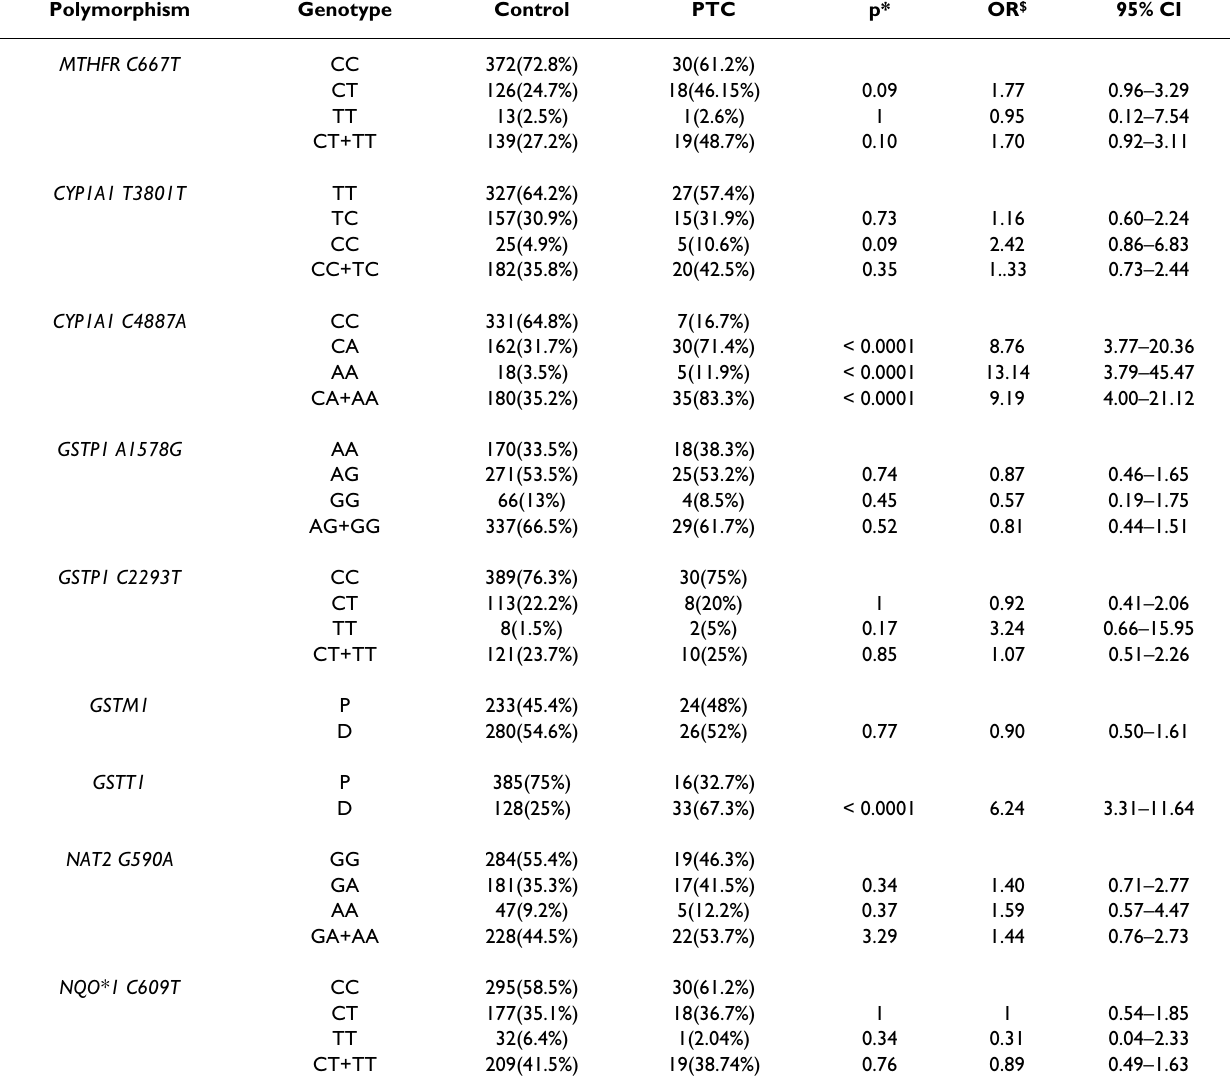
Table 1: Distribution of polymorphisms in healthy population and thyroid cancer patients (n =